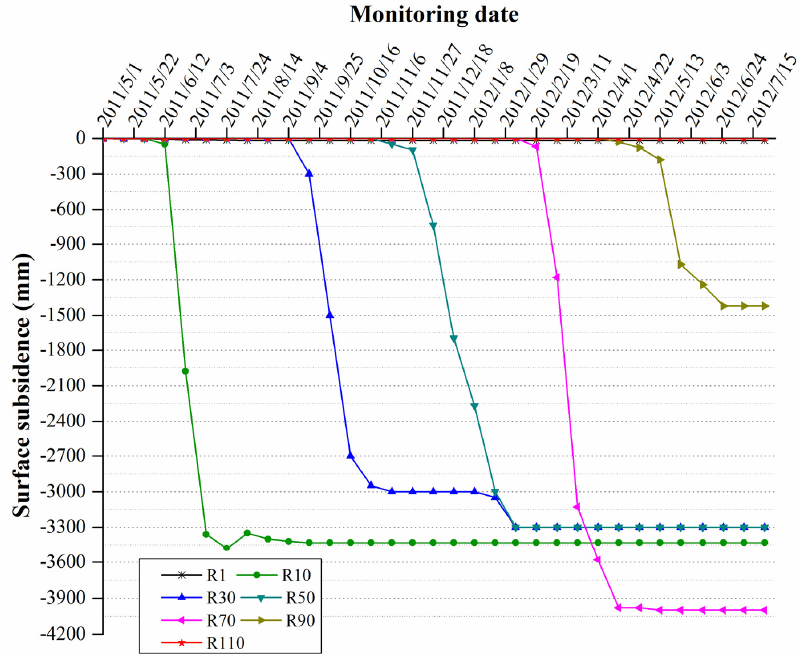
Figure 6. The subsidence results of representative GPS monitoring points on the R line above panel No. 222201. The layout of GPS points is shown in Figure 4.